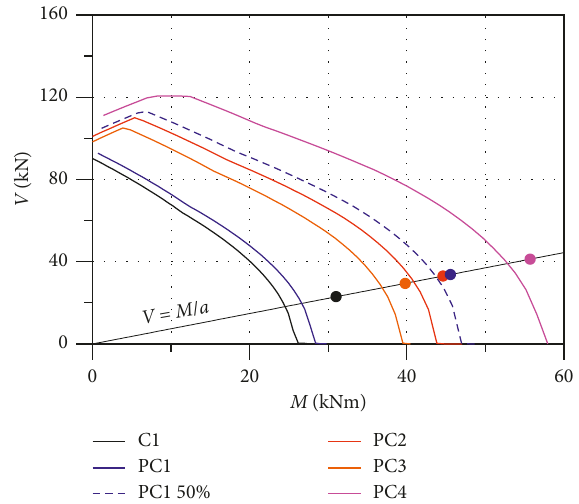
Figure 7: Interaction diagrams M - V for all specimens tested by Youn and Kim